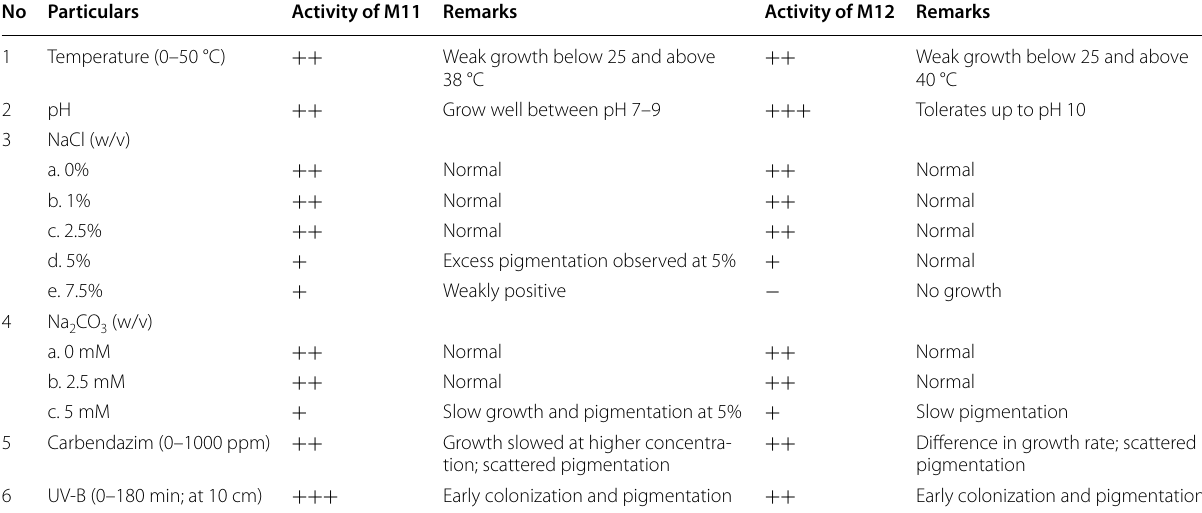
Table 3 Extremophilic characterization of Actinoalloteichus cyanogriseus isolates obtained from mulberry